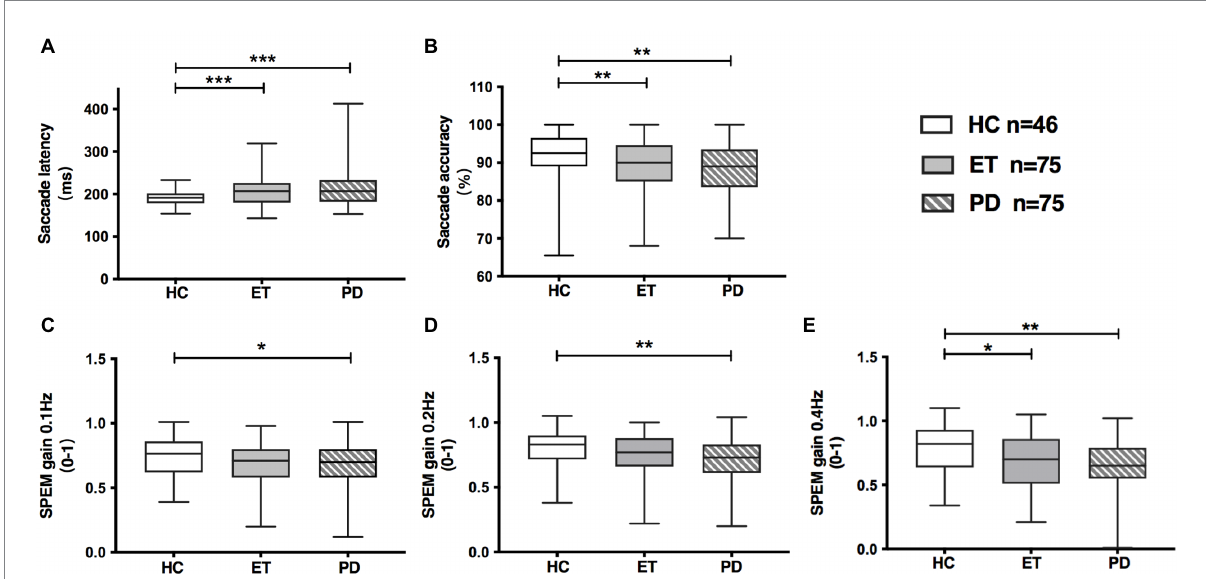
FIGURE 1 Oculomotor parameters in HC, ET and de novo PD patients. (A) Saccadic latency was increased both in ET and PD group, compared with HC group; (B) Saccadic accuracy was decreased both in ET and PD group, compared with HC group; (C,D) PD group had decreased gain of smooth pursuit eye movement at 0.1 Hz and 0.2 Hz, while ET group had marginally decreased gain of smooth pursuit eye movement at 0.1 Hz and 0.2 Hz, relative to HC group; (E) ET and PD patients had decreased gain of smooth pursuit eye movement at 0.4 Hz, relative to HCs. Box and whiskers (minimum and maximum) were presented for each group. Middle bars inside boxes represent median, while the edges of boxes indicate first and third quartiles. HC, healthy control; ET, essential tremor; PD, Parkinson’s disease; SPEM, smooth pursuit eye movement; * p < 0.05; ** p < 0.01; *** p < 0.001.